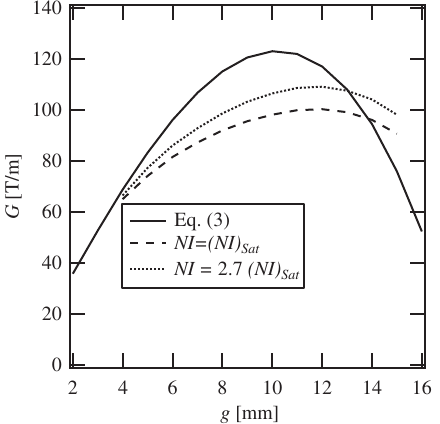
FIG. 8. Gradient vs gap between poles obtained from Eq. (3) and with a 3D model with Table III parameters ( r 1 ¼ 1 mm for the simulations shown in this plot). ð NI Þ The current density is 3 . 7 A = mm 2 at ð NI Þ . The bore radius is 12.5 mm. 2.7 ð NI Þ Sat